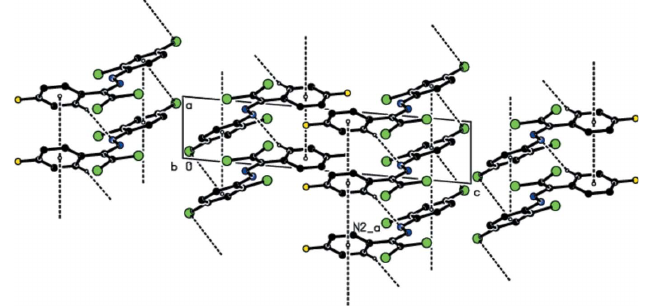
Figure 3 The crystal packing of the title compound viewed along the b axis with Figure 1